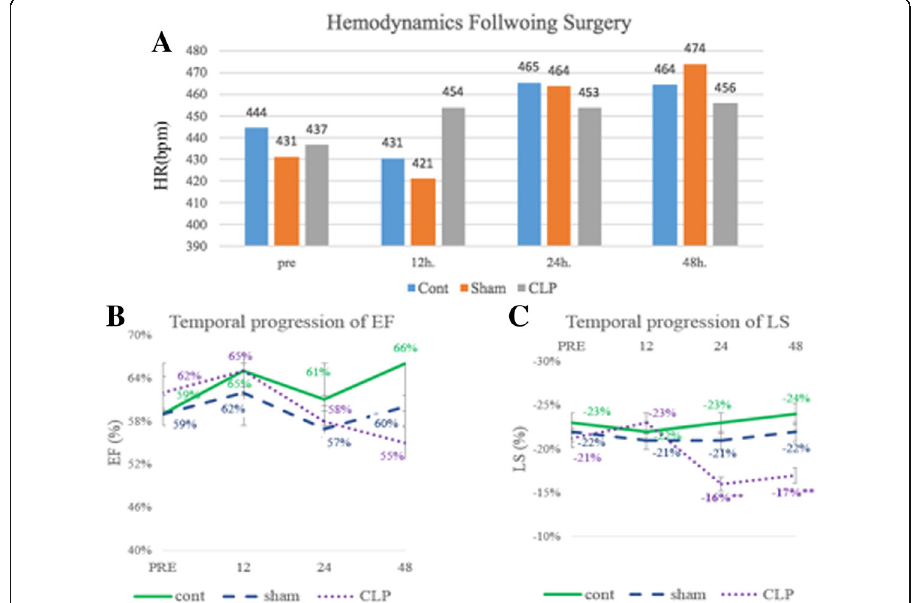
(EF = 59 ± 10%) with no significant difference in EF across the three groups (Table 1) [17]. Following the surgery, EF in the CLP group was not significantly depressed when compared with baseline (baseline = 59 ± 10%, 12 h = 65 ± 2.4%, 24 h = 58 ± 11%, 48 h = 55 ± 12%; p = 0.58) (Fig. 2b). Furthermore, there was no significant change in EF across the three groups (CLP, sham, and control) (Table 2).